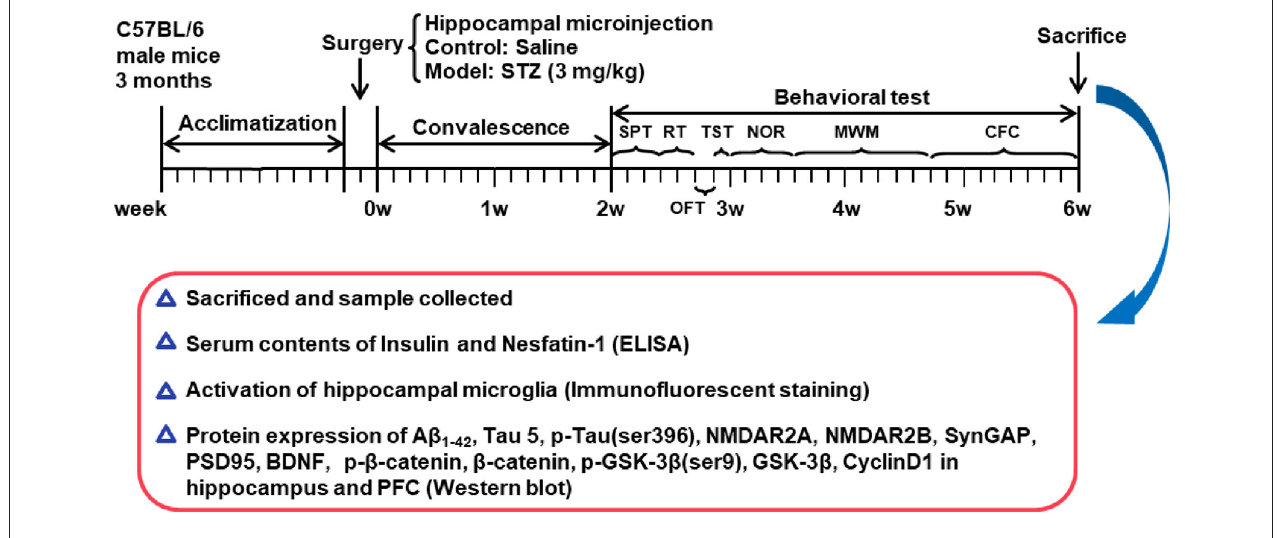
FIGURE 1 | Schedule of the experimental design. STZ, streptozotocin; SPT, sucrose preference test; RT, rotarod test; OFT, open field test; TST, tail suspension test; NOR, novel object recognition test; MWM, Morris water maze; CFC, contextual fear conditioning test; BDNF, brain derived neurotrophic factor; PFC, pre-frontal